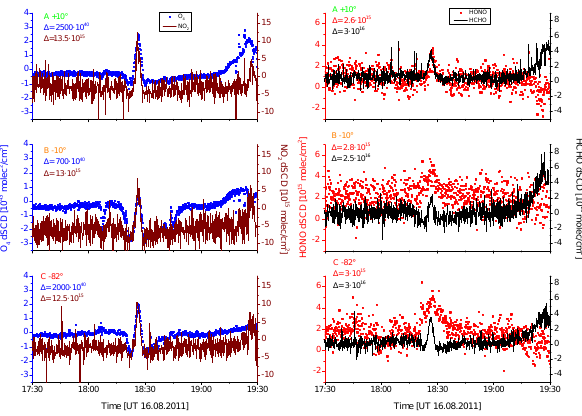
Figure 3. DOAS data for O 4 , NO 2 , HONO and HCHO (from left to right) for the three lines of sight, + 10 ◦ (top), − 10 ◦ (middle) and nadir (bottom). When flying through the cloud a strong increase in all these time series is observed. Especially for the downward- looking telescopes the O 4 column densities are reduced relative to the background, while the aeroplane flies over the cloud. The dif- ference between the background level and the enhancement inside the cloud is given as 1 SCD in the figures.